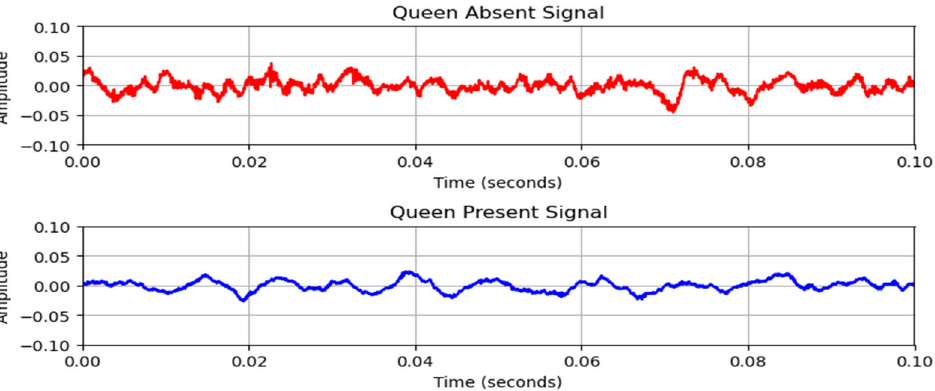
Figure 9. Plots of randomly selected 1 s clips for Queen Absent top (red) and Queen Present bottom (blue) audio signals.